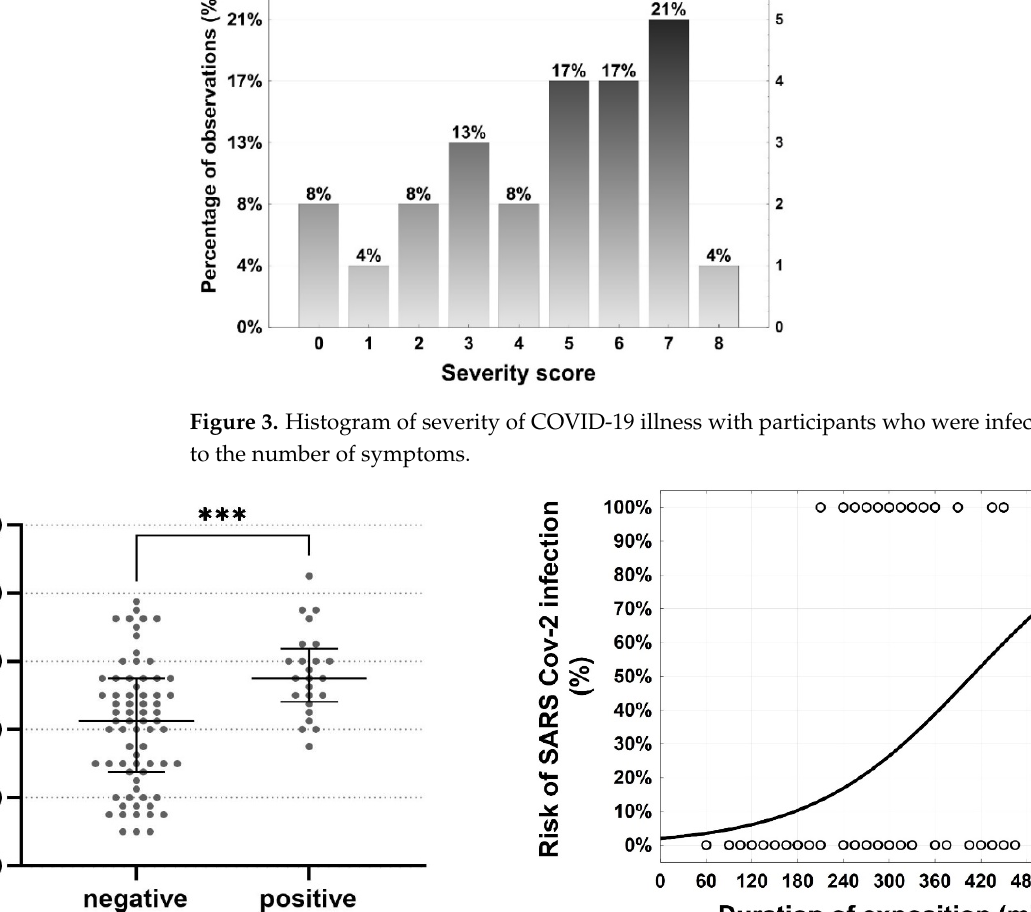
( b ) Figure 2. ( a ) Schematic overview of interactions between guests at the event (with individual “4-1” exemplary highlighted). Each guest is represented by a node, and all interactions longer than 10 min and with a distance less than 1.5 m are represented as edges between the nodes. The color of the